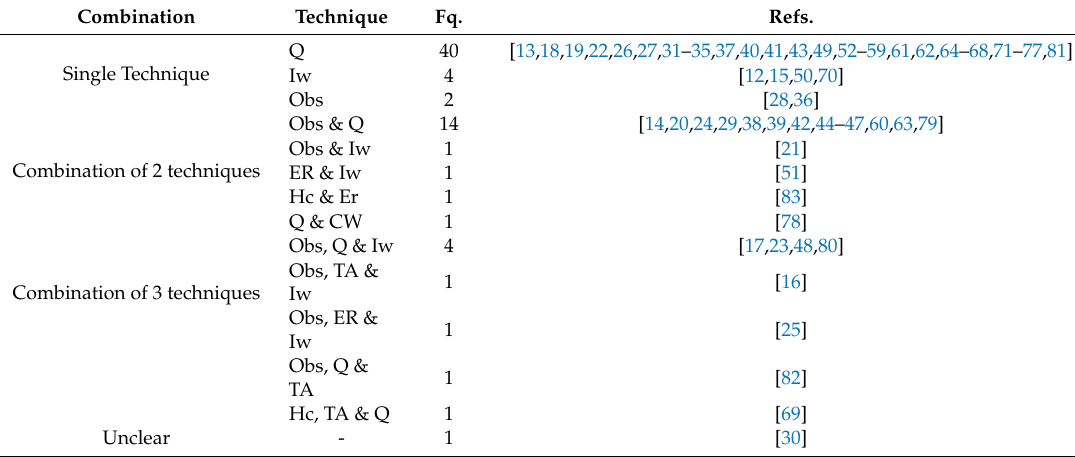
Table 14. Usability technique